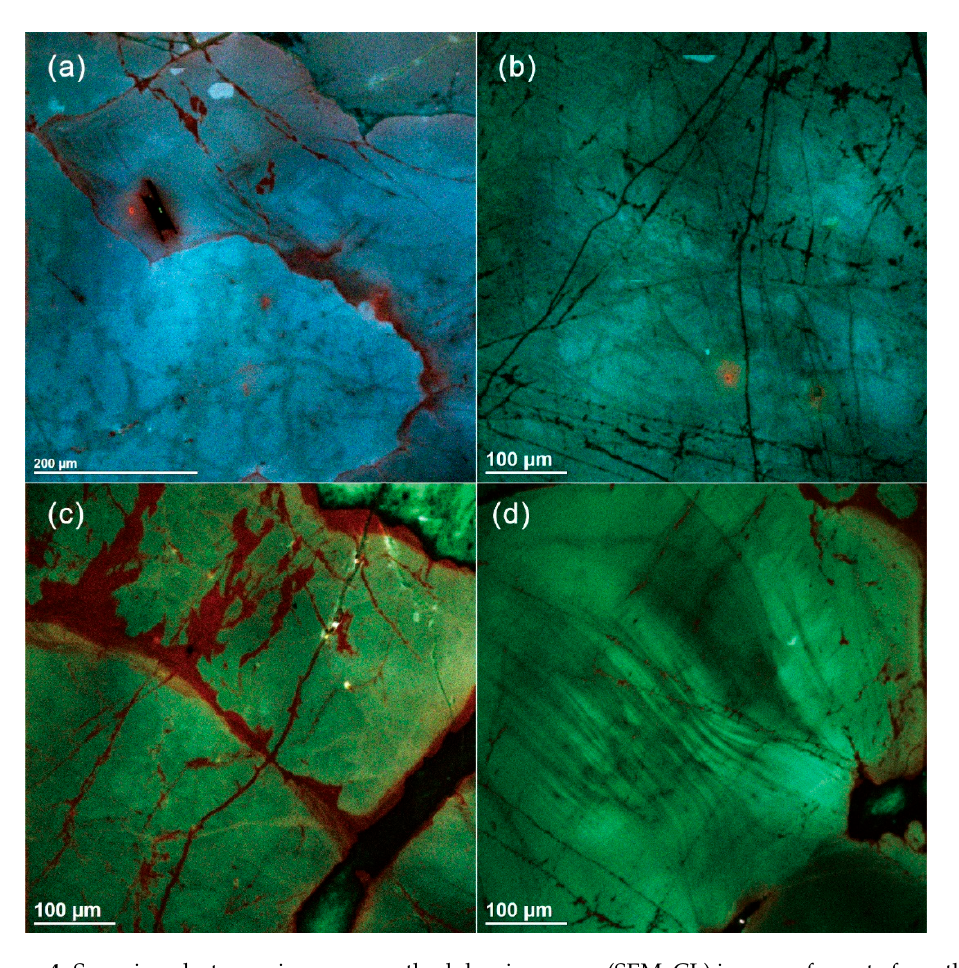
Figure 3. Chondrite-normalized [25] rare earth elements of zircons from the two-mica granite ( a ) and biotite granite ( b ).